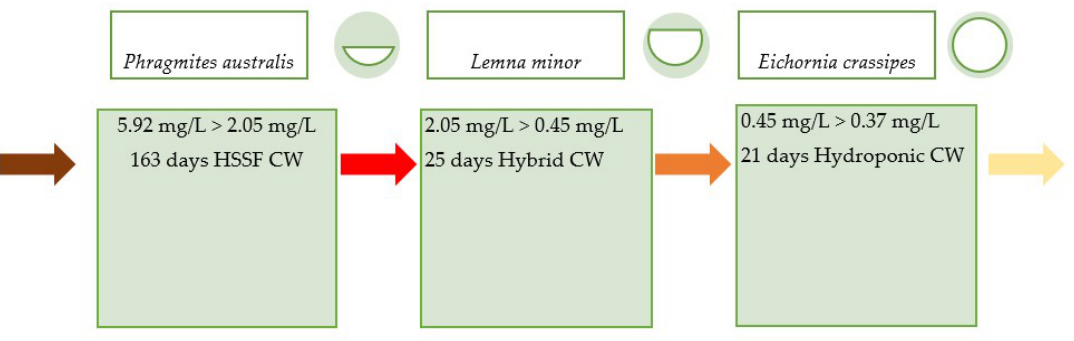
Figure 5. Plant sequence as biosorbents and the effect of reducing Hg concentration in water.